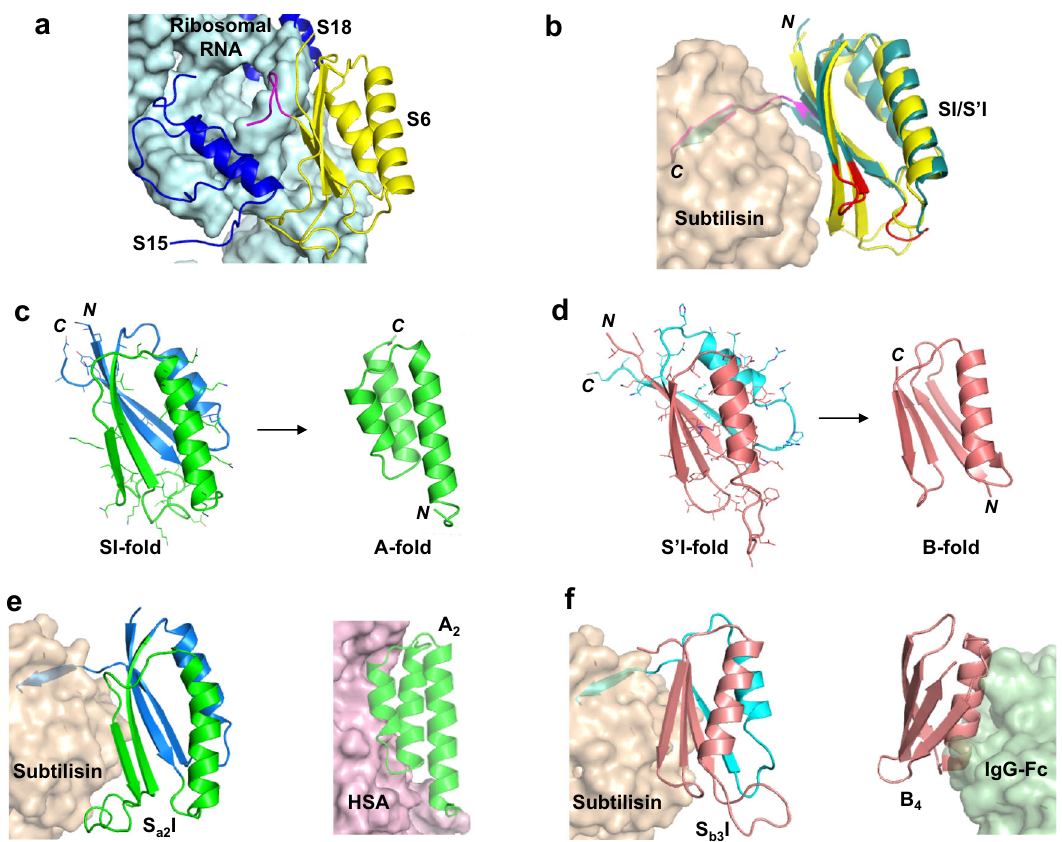
Fig. 2 | Summary of switches in structure and function. a Structure of the S6 protein (yellow), RNA (light blue), and S15 and S18 proteins (blue) in the 30S ribosome (PDB 1FKA [https://doi.org/10.2210/pdb1FKA/pdb], ref. 43 ). C-terminal amino acids of S6 are in magenta. b Subtilisin (wheat) is shown in complex with a modelofthe SI-inhibitor(yellow). The C-terminalnine amino acids of SIare shown in magenta. These positions were mutated in native S6 to generate af fi nity for subtilisin. The S ’ I-inhibitor (teal) is also shown with the altered loops in red. The subtilisinusedinthe modelingwas theengineered RAS-speci fi cprotease. c The S a1 protein (blue and green) was generated from SI by mutating the 45 positions (mutant side chains shown with sticks). Deletion of C-terminal amino acids (blue)